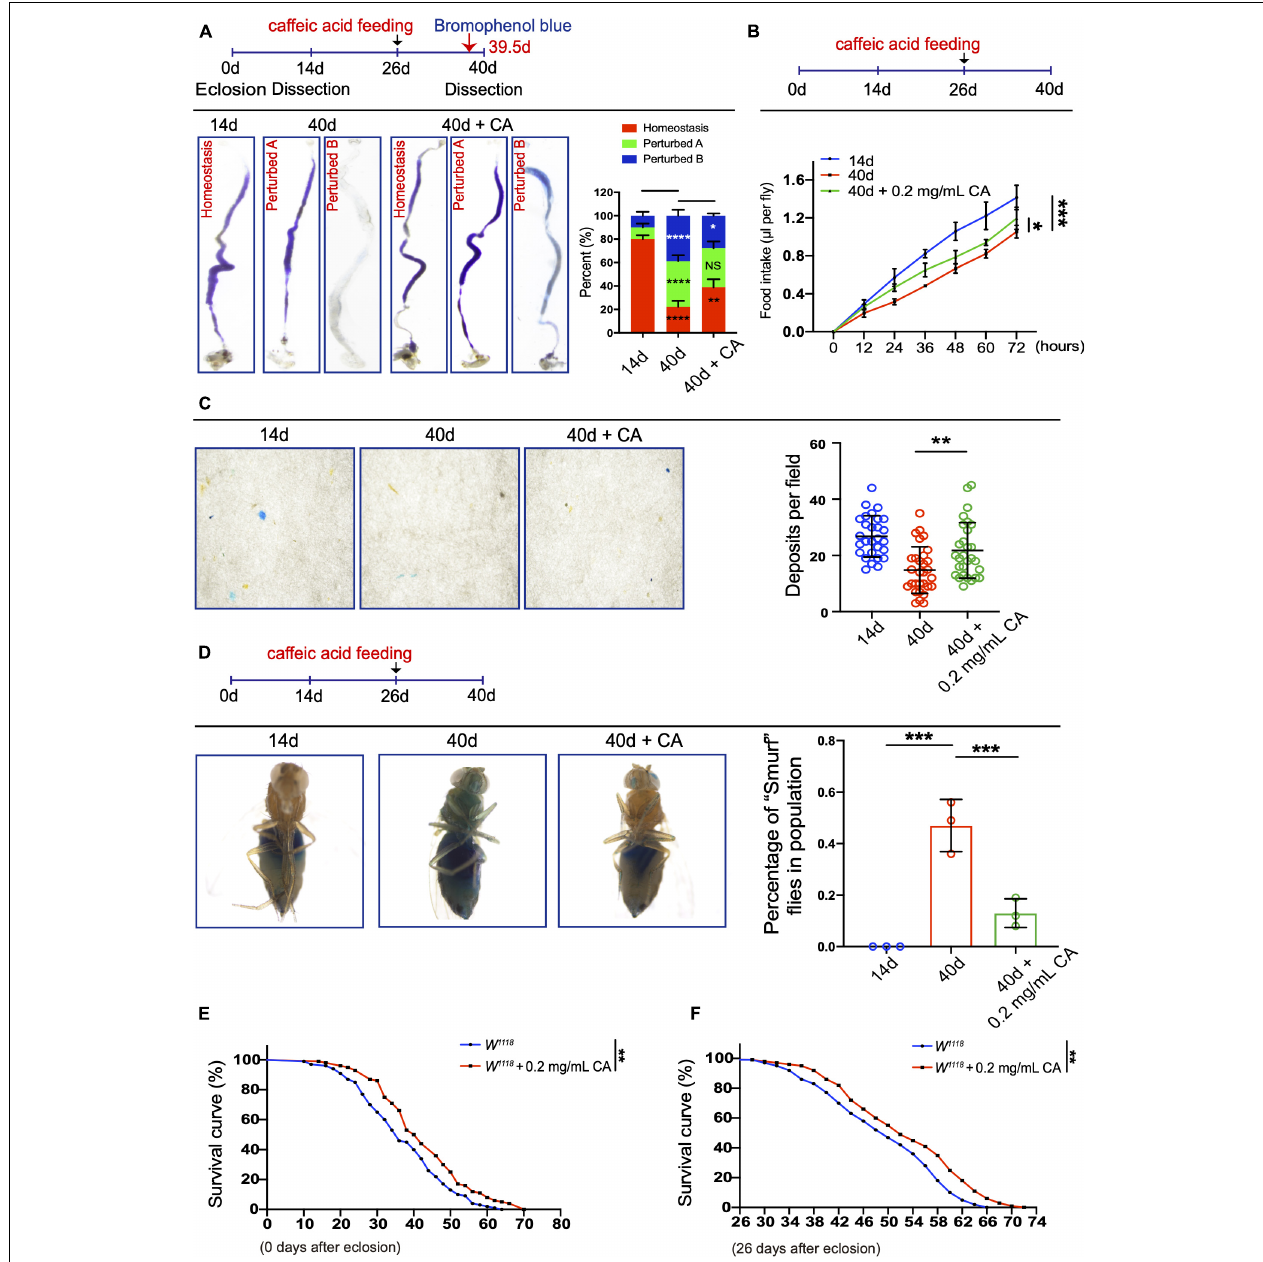
FIGURE 2 | Inhibitory effects of CA on the age-related decline in intestinal functions. (A) Typical images (left) and quantification (right) of GI tract of Drosophila fed with the pH indicator Bromophenol Blue. There are three types of the GI tract of flies fed with Bromophenol blue, including “Homeostasis,” “Perturbed A,” and “Perturbed B.” N = 90 flies per group. The P -values between 14-day and 40-day are highlighted in the 40-day column. The P -values between 40-day and 40-day with 0.2 mg/mL CA supplementation are highlighted in the 40-day with 0.2 mg/mL CA column. Error bars represent the SD of three independent experiments. (B) CAFE assay was used to measure food intake in 14- (the blue line), 40- (the red line), and 40-day flies in response to 0.2 mg/mL CA supplementation (the green line). Error bars represent the SD of three independent experiments. (C) Representative images (left) and quantification (right) of excretion from flies fed with Bromophenol Blue. Excretions are quantified for 28, 30, and 29 fields in each group of 12 flies. 28, 30, and 29 represent the field and the deposits were counted per field. Error bars represent the SD of three independent experiments. (D) Representative images (left) and quantification (right) of the percentage of “Smurf” flies of 14-, 40-, and 40-day with 0.2 mg/mL CA supplementation after consuming a non-absorbed food dye. Error bars represent the SD of three independent experiments. (E) Life span assay. Survival curve (%) of female W 1118 flies treated with (marked with the red curve) or without (marked with the blue curve) 0.2 mg/mL CA starting from the day after eclosion. N = 100 flies per group. Three independent experiments were performed. (F) Life span assay. Survival curve (%) of female W 1118 flies treated with (marked with the red curve) or without (marked with the blue curve) 0.2 mg/mL CA starting from the 26th-day post-eclosion. N = 100 flies per group. Three independent experiments were repeated. Error bars represent SDs. One-way ANOVA test, Log-rank test for panels (E,F) . * P < 0.05, ** P < 0.01, *** P < 0.001, **** P < 0.0001, and non-significant (NS) represents P > 0.05.